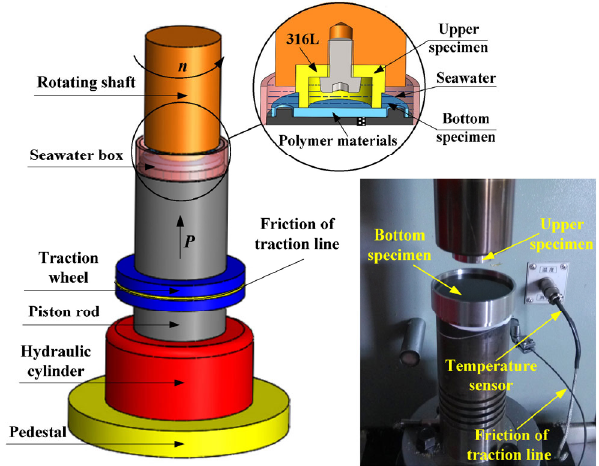
Installation drawing of ring-on-disc configuration.